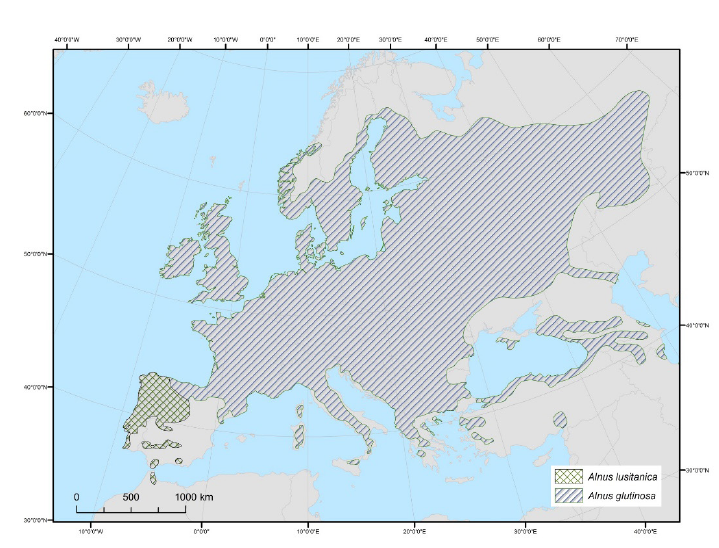
Figure 1. Geographical distribution of Alnus glutinosa s. str. in Europe according to the Chorological maps for the main European woody species (Caudullo et al ., 2017), and approximate distribution of A. lusitanica according to the geographical information provided by Vít et al .